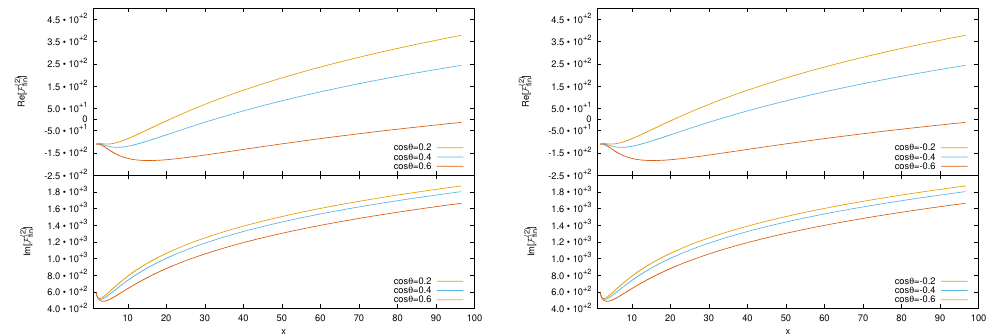
(2) as a function of variable x for di(cid:11)erent (cid:12)n F